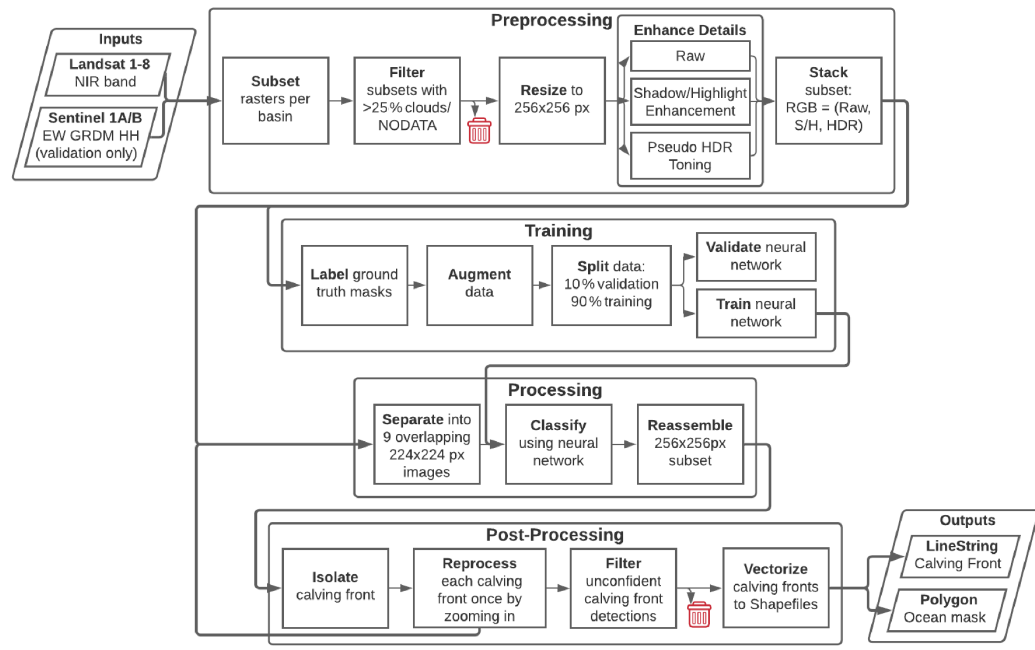
Figure 3. Methodology flowchart. The CALFIN workflow, which processes single band raster imagery into calving front and ocean mask shapefiles. Note that Sentinel-1A/B imagery is only used for validation, as it is not corrected and thus not qualified for geolocation/extraction.